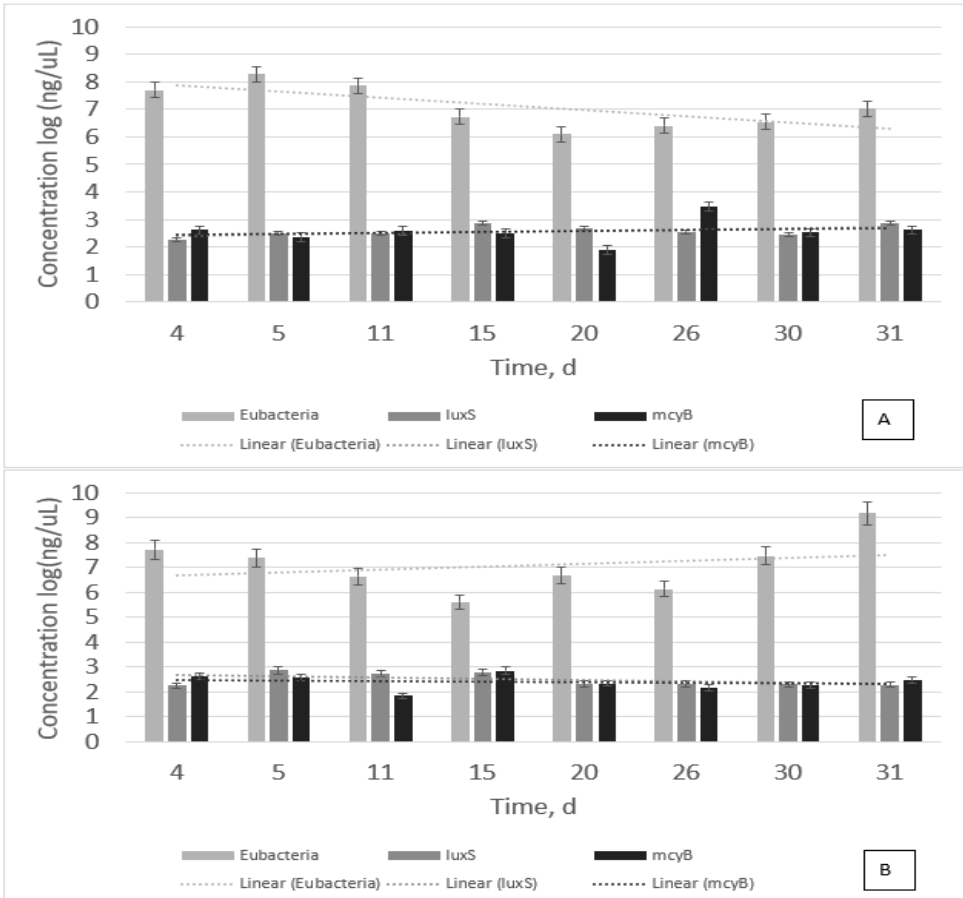
Figure 1. Combined results of gene expression for non-treated ( A ) and treated samples ( B ). Error bars represent the standard deviation of triplicates.